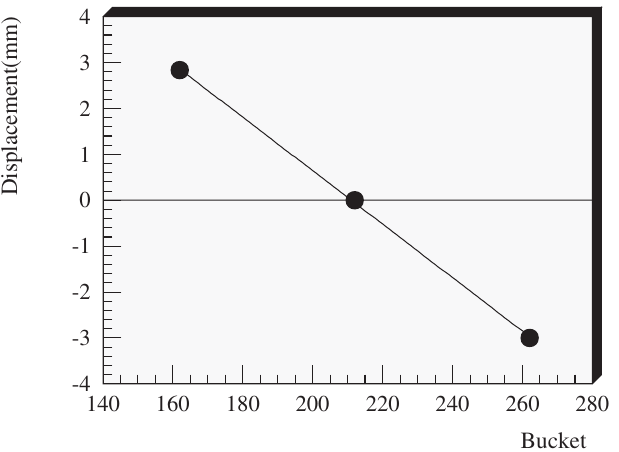
FIG. 3. Displacement between the 1st and 6th bunches in the ILC mode as a function of the relative bucket offset. The displacement is minimized at the expected position where the two bunches fully overlap each other.